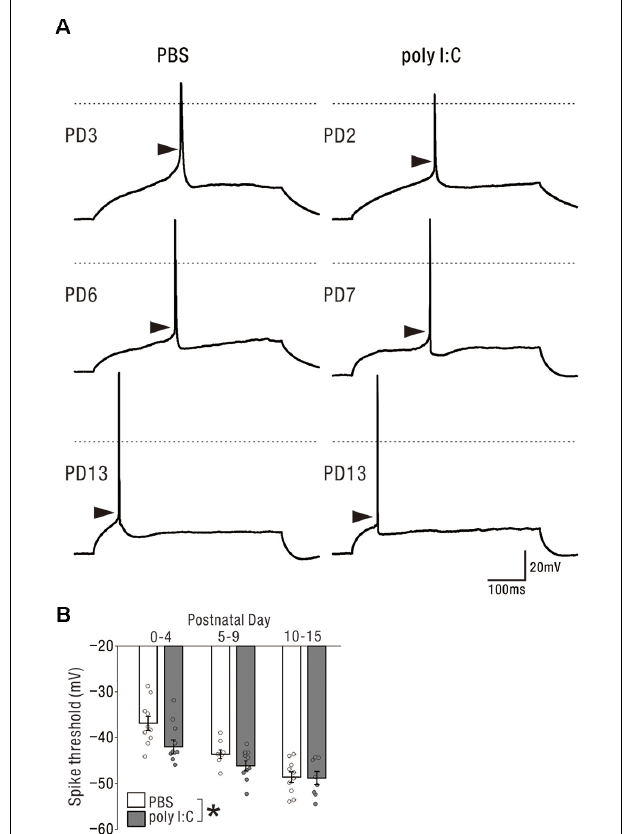
FIGURE 6 | Prenatal poly I:C treatment lowered the action potential threshold of pyramidal cells in the neonatal period. (A) Representative traces showing action potentials elicited by the rheobase current injection. Each arrow head indicates the estimated threshold voltage for action potential generation. In each traces, 0 mV level in membrane potential is shown as a horizontal dotted line. (B) There was a significant difference in action potential threshold between PBS-treated and poly I:C-treated mice, * p < 0.05. Data are presented as means, and error bars indicate SEM. Poly I:C, polyriboinosinic-polyribocytidilic acid; PBS, phosphate-buffered